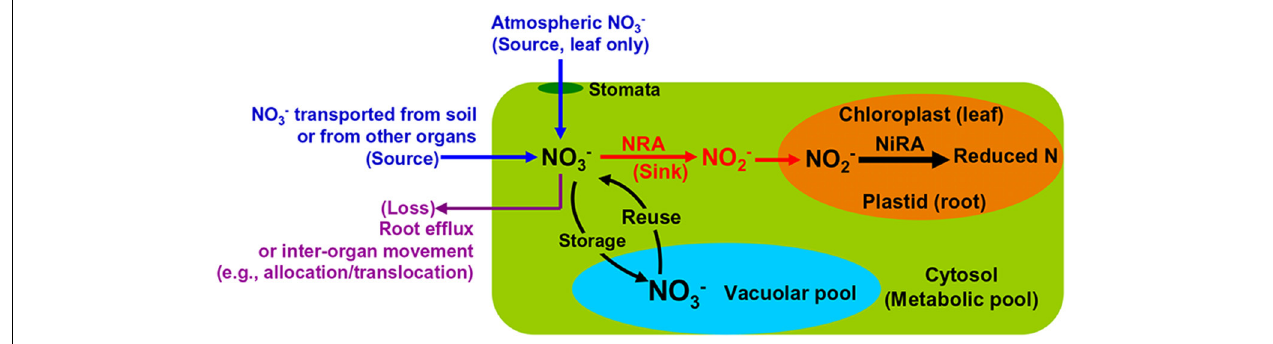
FIGURE 2 | Schematic map showing major NO − 3 sources and processes in leaves and roots of natural plants.